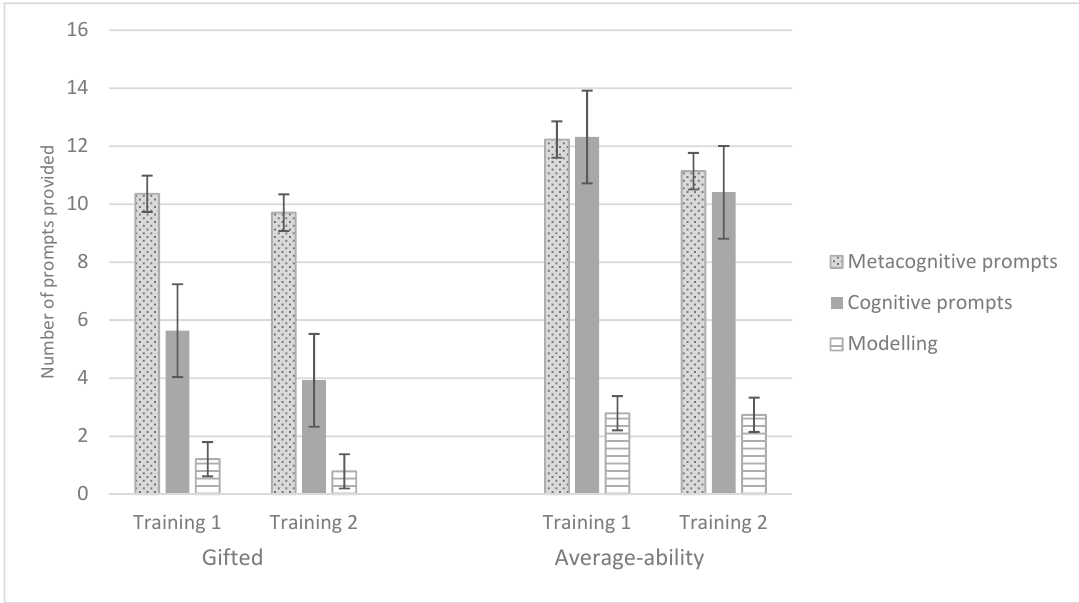
Figure 3. Number of metacognitive, cognitive and modelling prompts for both training sessions and ability groups. Error bars denote standard errors.